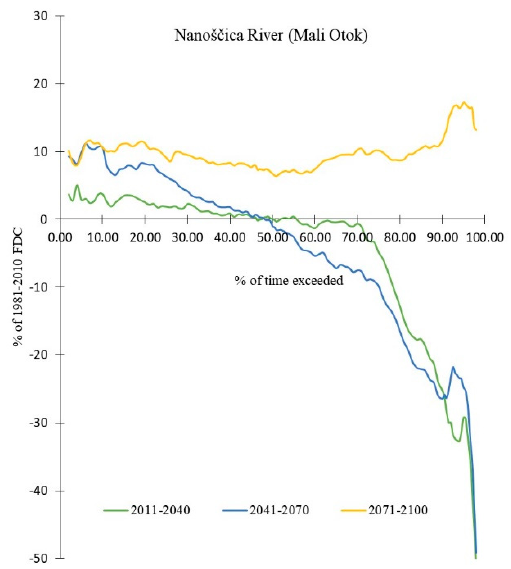
Figure 8. Flow duration curve (Q2–Q98) comparison for the three investigated time periods where the median curve is shown for the Mali otok station (Nanoš č ica River).